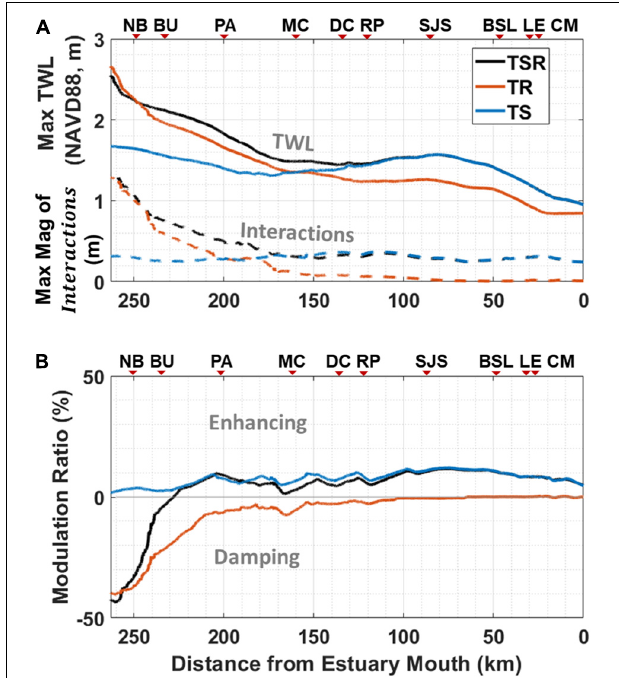
FIGURE 12 | Along estuary variations in the TSR run (black), TR run (red), and TS run (blue) of (A) peak values of TWL and peak magnitude of non-linear interactions, (B) modulation ratio by non-linear interactions on